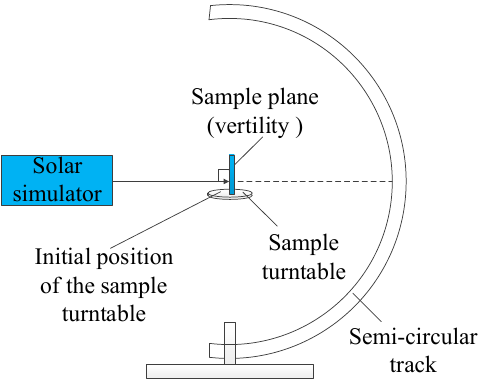
Figure 10. The sketch of calibration of initial position of the sample turntable.